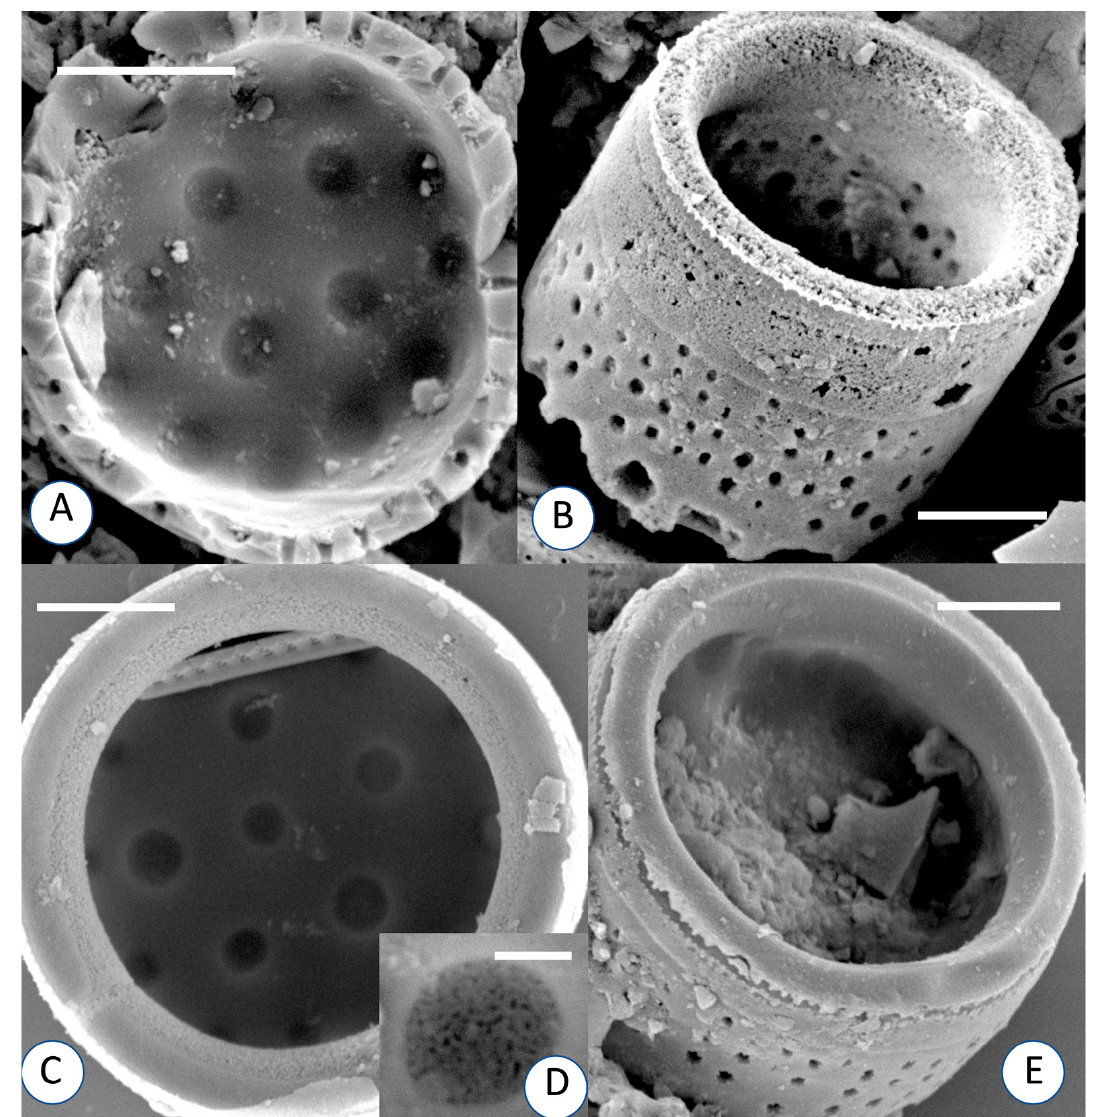
Figure 4. ( A – C ) Aulacoseira wyomingensis , sp. nov. Scanning electron microscopy. Internal views. ( A ) Valve view showing areolae and interior of valve. Scale bar = 2.5 µm. ( B ) Side view showing part of valve interior and exterior. Scale bar = 2.5 µm. ( C ) Valve view of interior showing ringleiste. Scale bar = 2.5 µm. ( D ) High magnification view of single areola showing fine hymenate occlusion over opening. Scale bar = 0.3 µm. ( E ) Side view showing part of the valve interior and exterior. Scale bar = 2.5 µm.